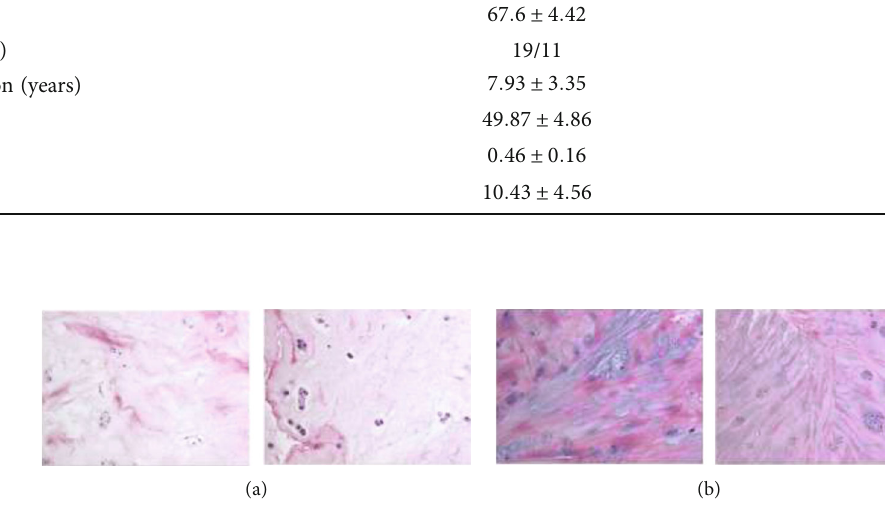
Figure 1: The pathology of control cartilages and OA cartilages is shown in (a) and (b).